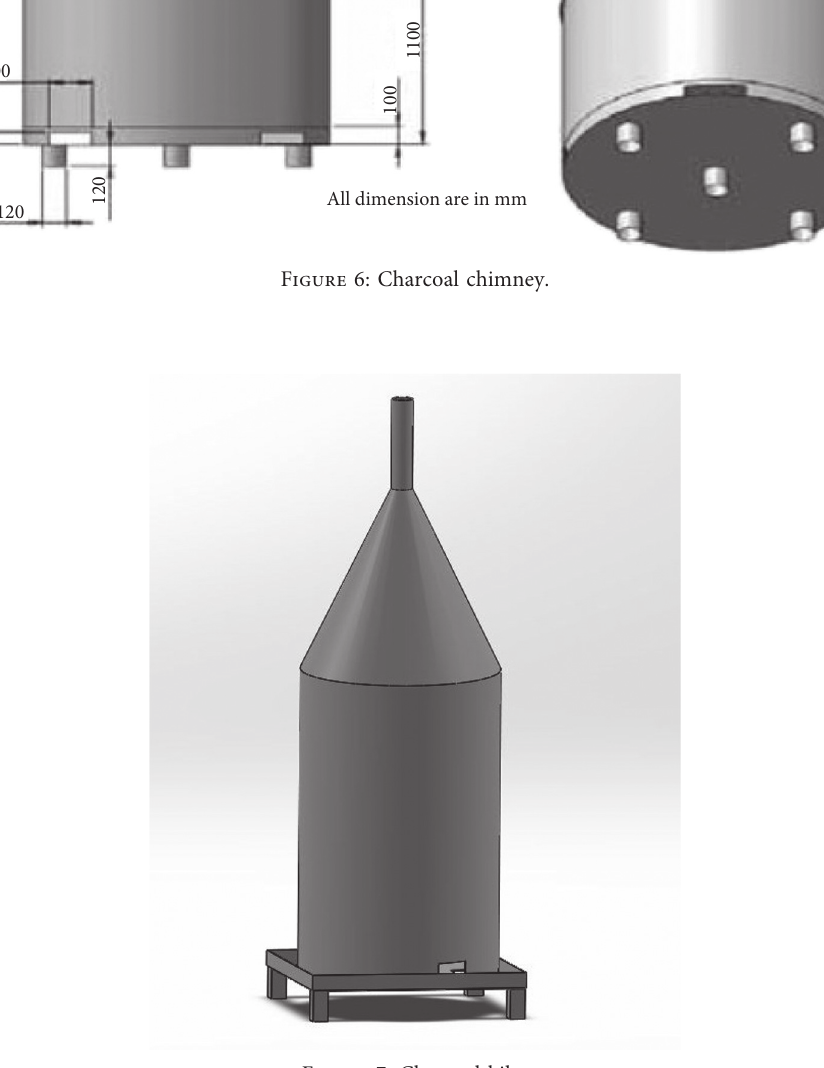
Figure 7: Charcoal kiln.